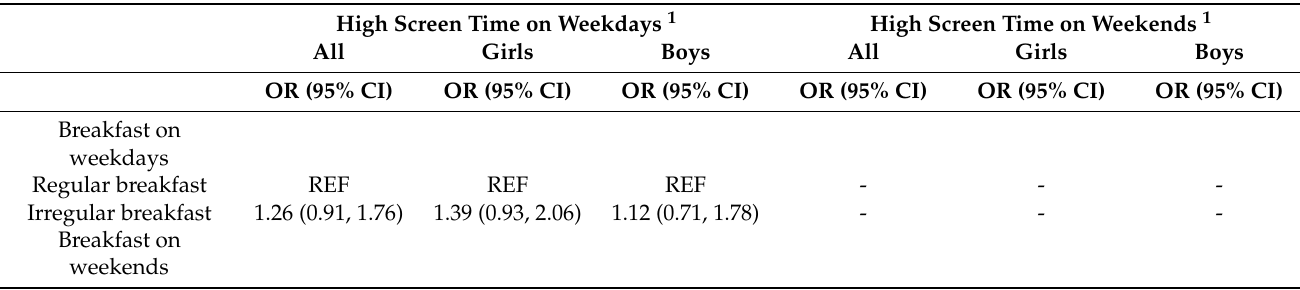
Table 3. Associations between breakfast (exposure) and high screen-time variables (outcomes). High Screen Time on Weekdays